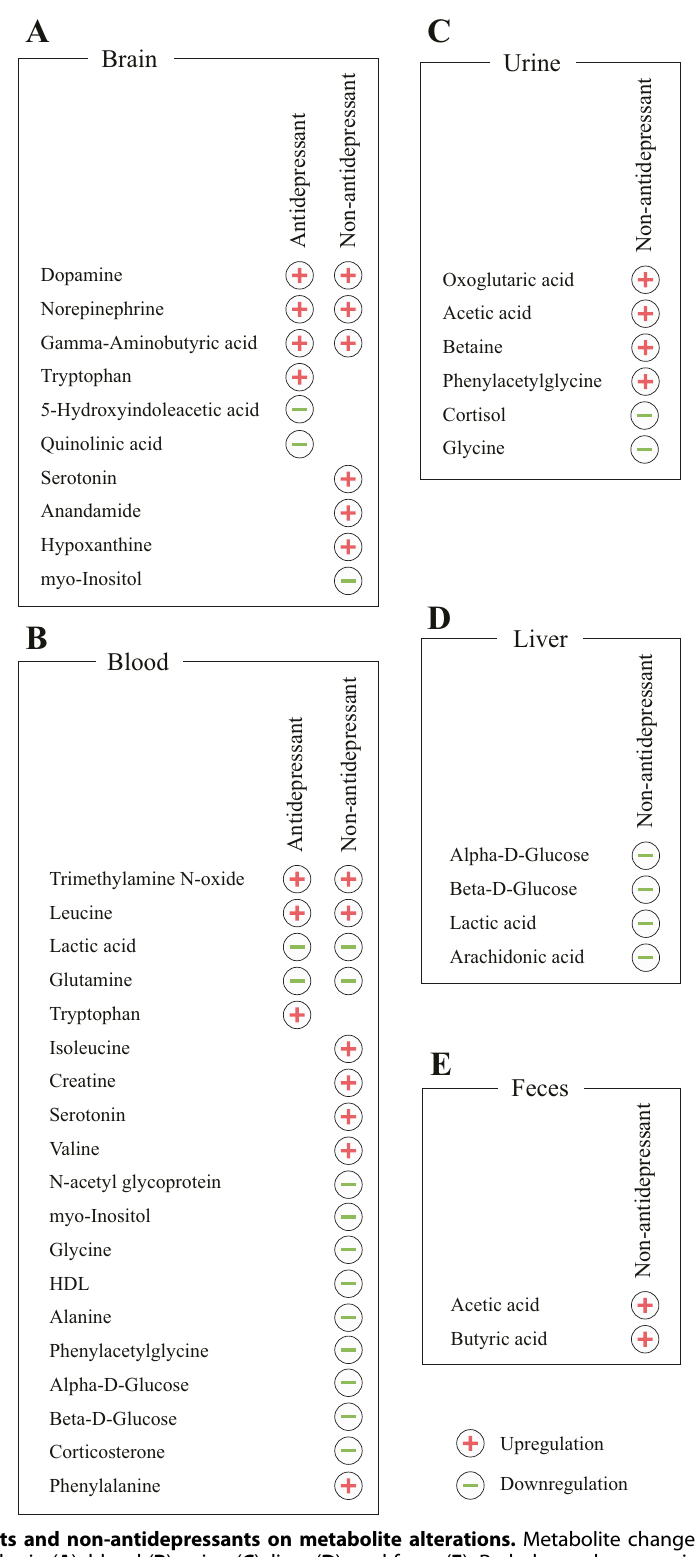
Fig. 5 Effects of antidepressants and non-antidepressants on metabolite alterations. Metabolite changes resulting from antidepressants and non-antidepressants in the brain ( A ), blood ( B ), urine ( C ), liver ( D ), and feces ( E ). Red plus and green minus signs in the diagram indicate signi fi cant upregulation and downregulation,